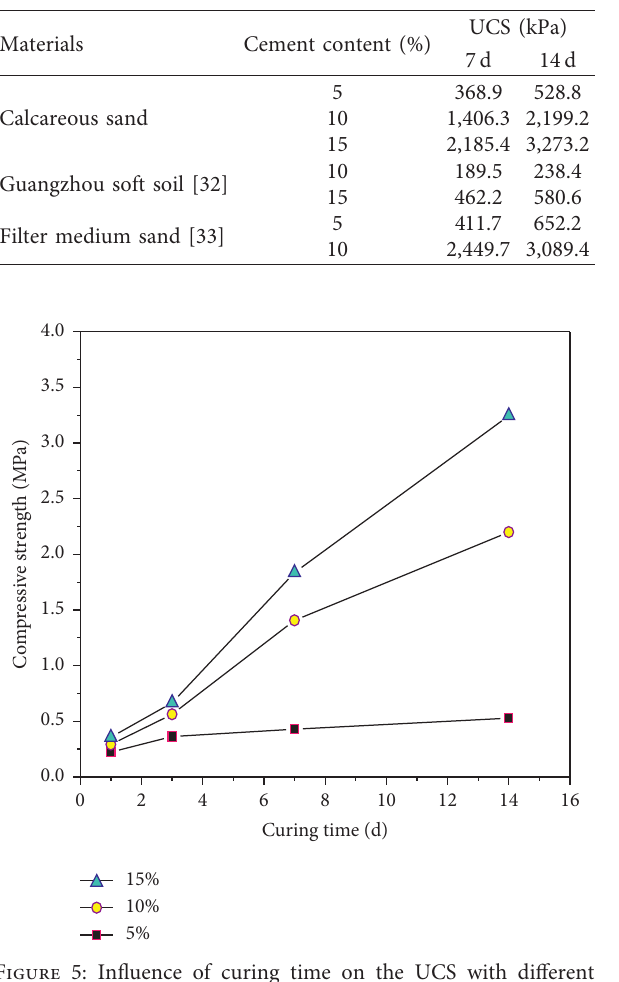
Figure 5: Influence of curing time on the UCS with different cement